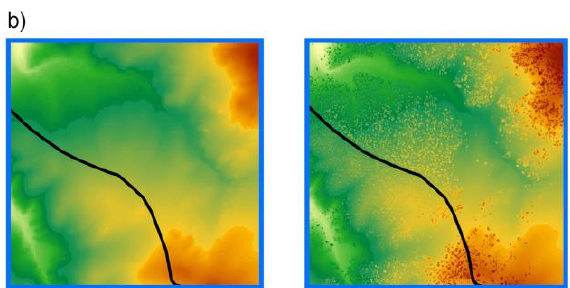
Figure 3. (a) LiDAR dataset with a point cloud density representation, and (b) detail of the rasters DEM (left) and DSM